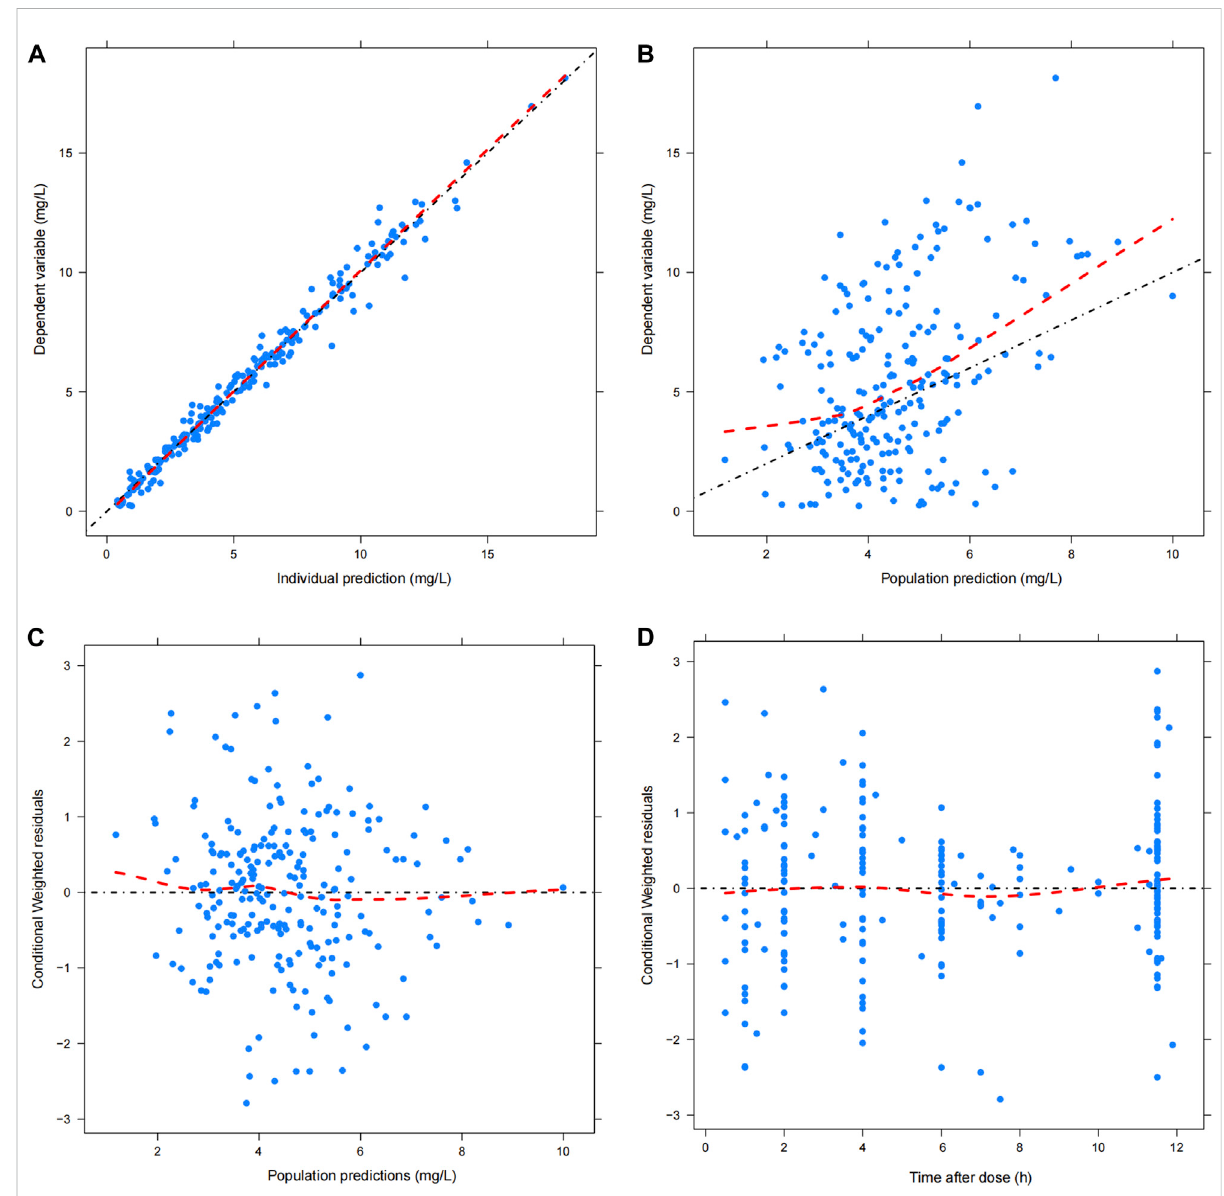
FIGURE 1 Goodness of fi t plot of fi nal model. (A) Scatter plot of observed value and individual predicted value; (B) Scatter diagram of observed value and population predicted values; (C) Scatter plot of conditional weighted residuals and predicted population value; (D) Scatter plot of conditional weighted residuals and time after dose. The black dotted line is the reference line, and the red dotted line is the LOESS trend